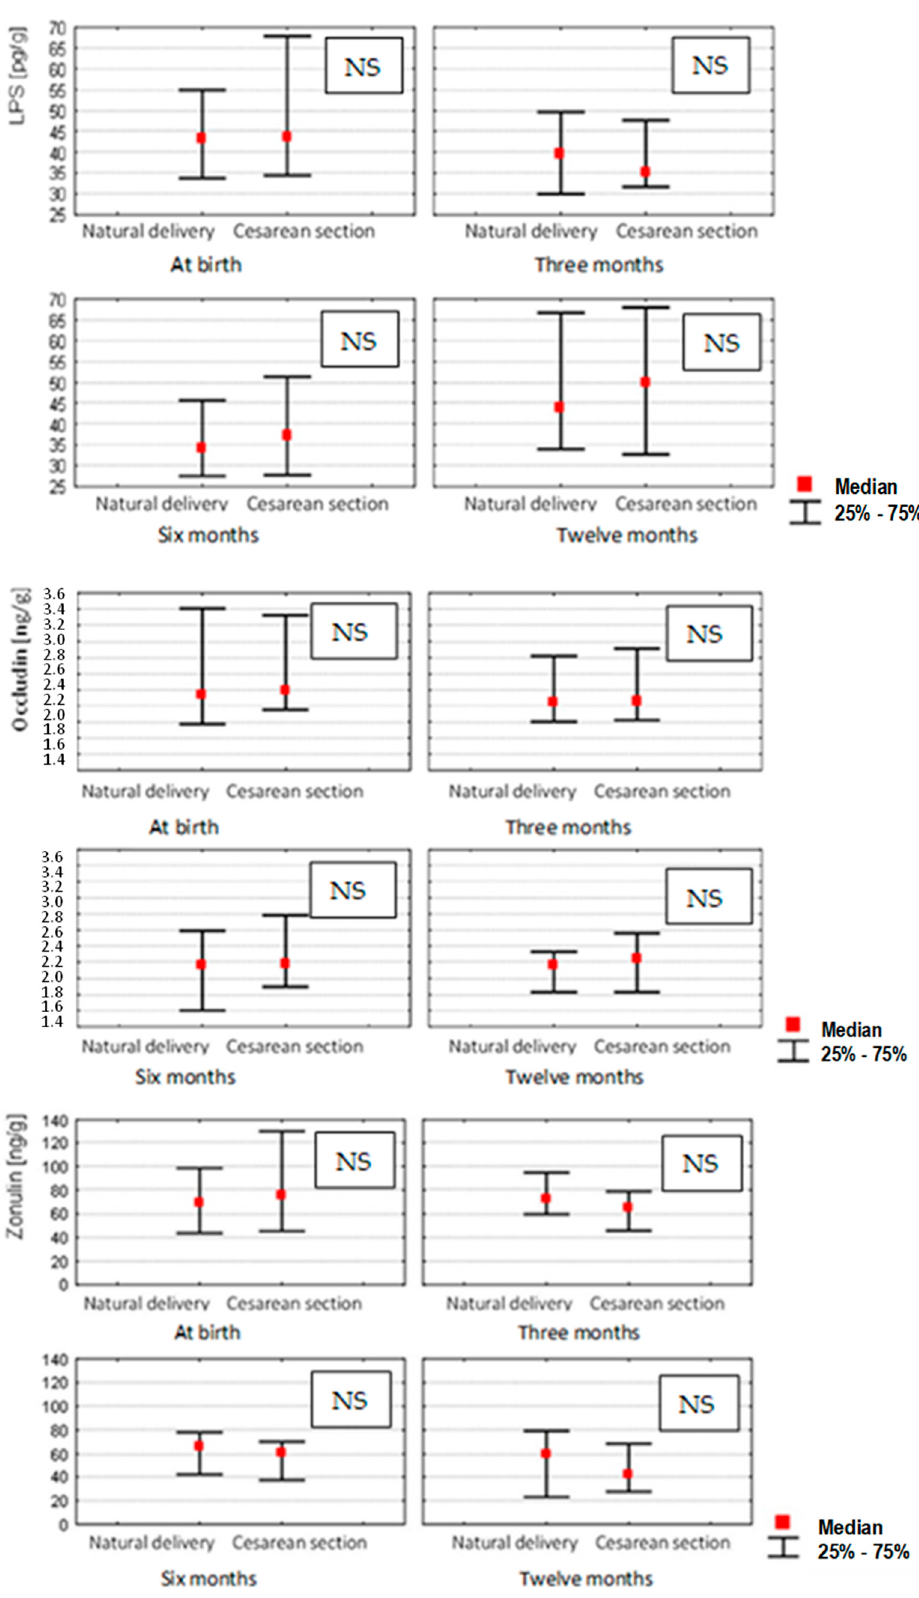
Figure 2. Stool concentrations of studied parameters for 0 ( n = 100), 3 ( n = 96), 6 ( n = 90) and 12 ( n = 84) month-old children depending on the method of delivery (Mann–Whitney U test and Kruskal–Wallis test; p -value ≤ 0.05 was considered statistically significant. NS: non-significant).